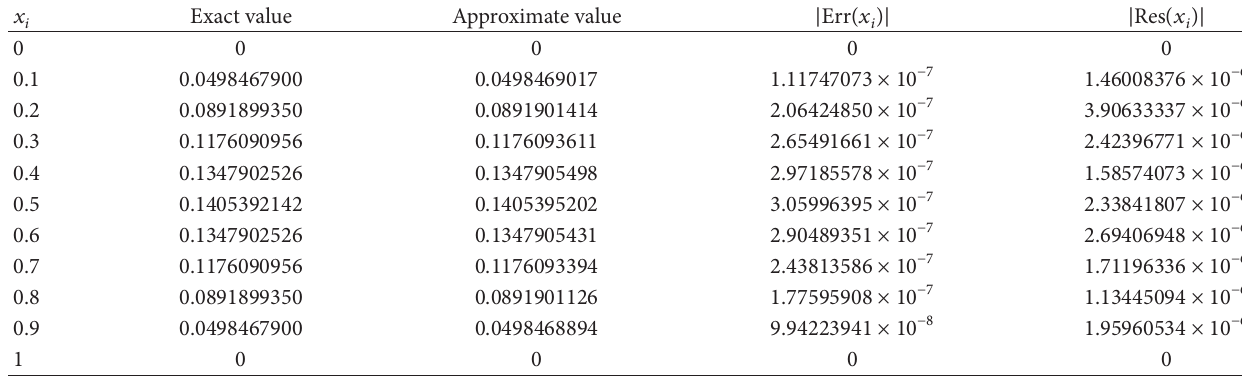
Table 3: Numerical results for Bratu’s problem when 𝜇 = 1 .